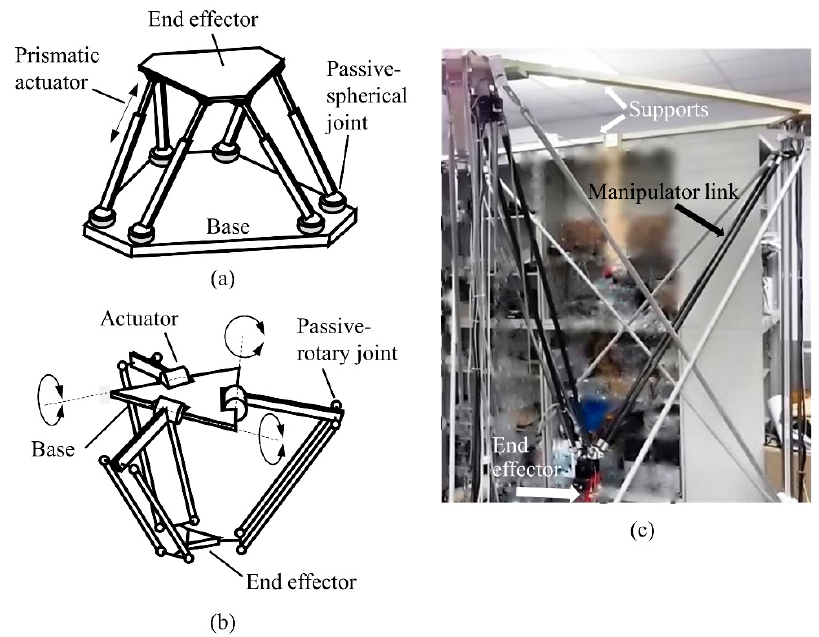
Figure 5. ( a ) Parallel manipulator structure; ( b ) delta manipulator structure; ( c ) delta manipulator (courtesy of Professor J. Lin, Chien Hsin University of Science and Technology [29]).